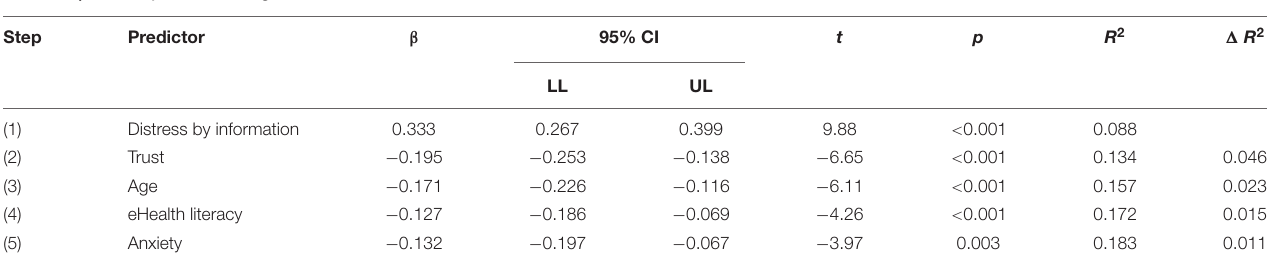
TABLE 2 | Summary of the final regression model on information